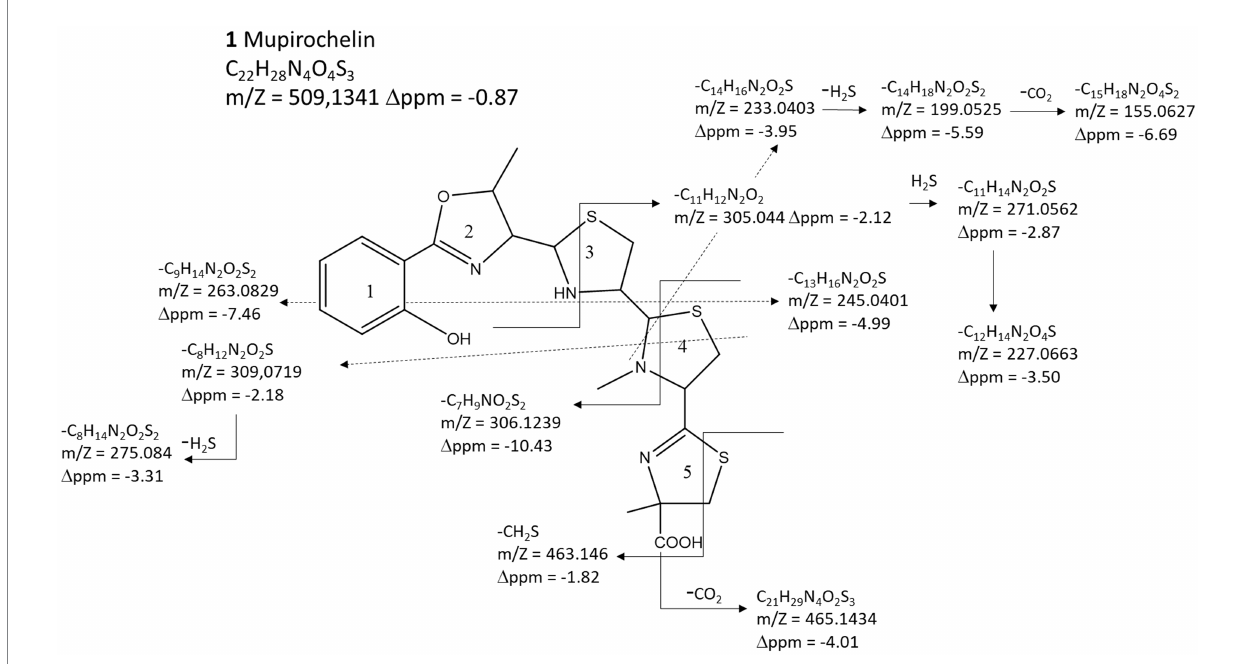
FIGURE 3 Structure prediction of mupirochelin. Predicted chemical structure of mupirochelin based on its MS/MS fragmentation pattern. Each arrow represents the cleavage of a particular